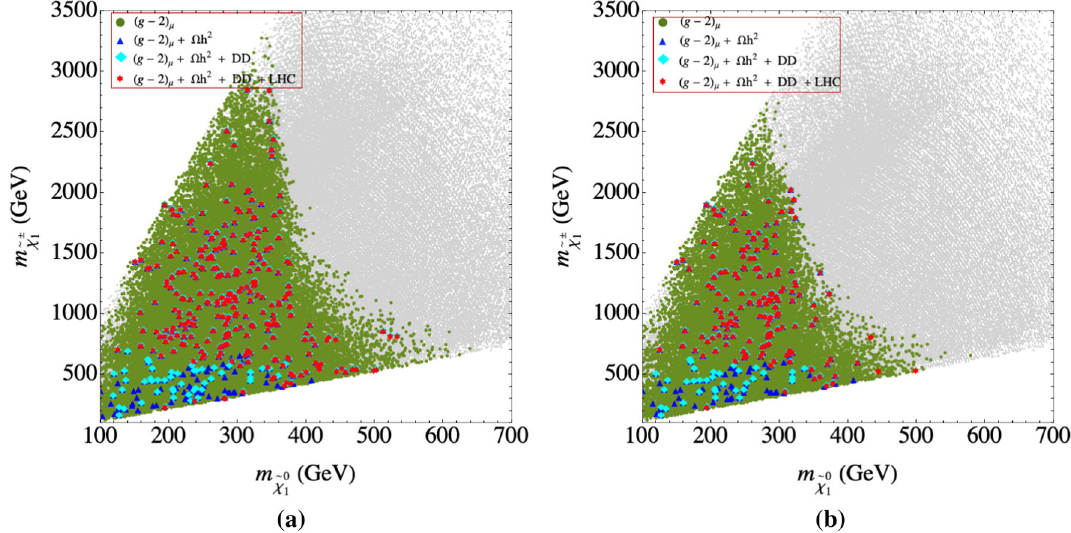
− m plane for the ˜ l ± -coannihilation Case-L (current (left) and anticipated future limits ˜ χ 0 1 1